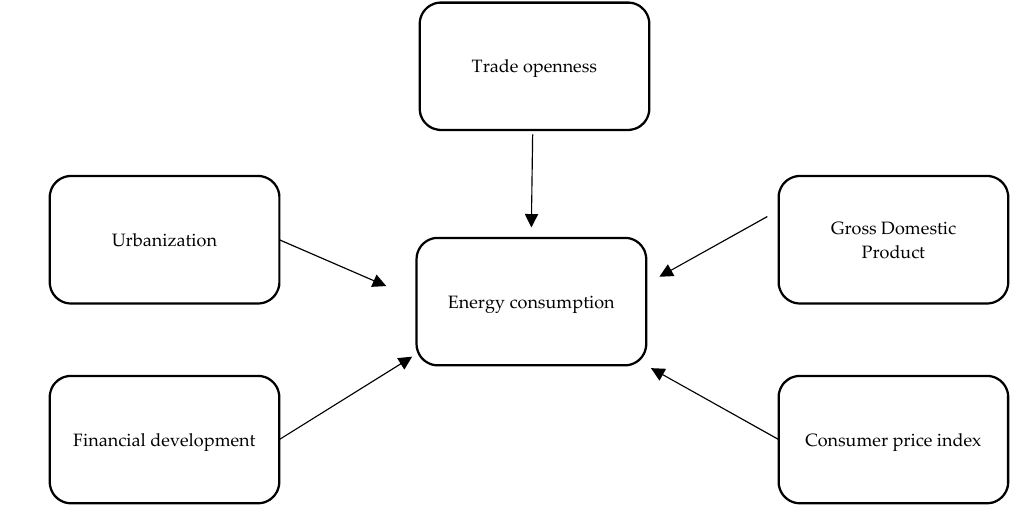
Figure 1. Determinants of energy consumption.